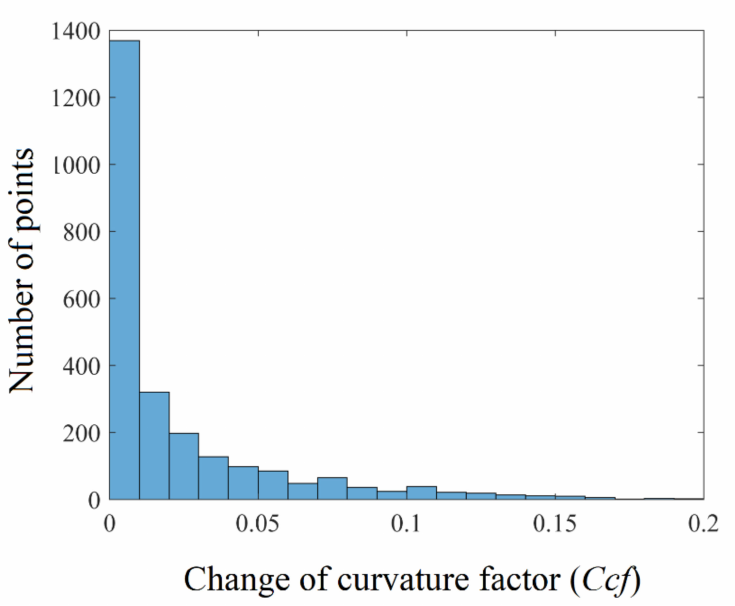
Figure 6. Histogram of change of curvature factor ( C cf ) of noisy point